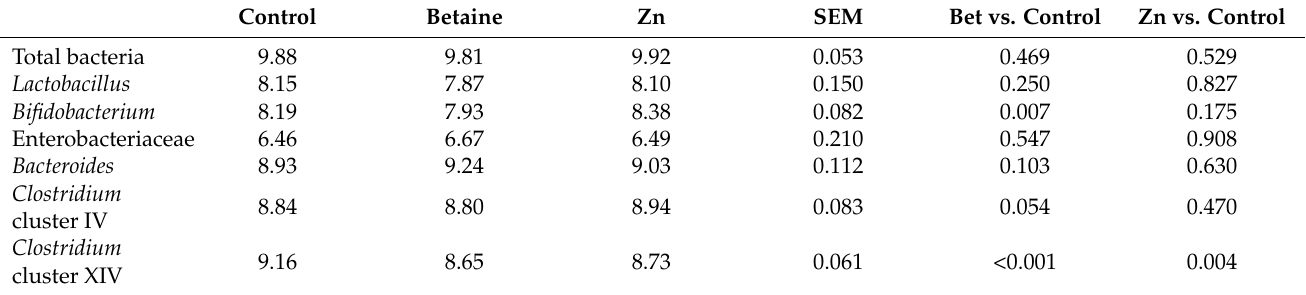
Table 5. Mean values of bacterial group abundance (log CFU equivalents/g fresh matter) determined by quantitative PCR in Iberian pigs ( n = 8/diet) fed a standard diet supplemented or not with